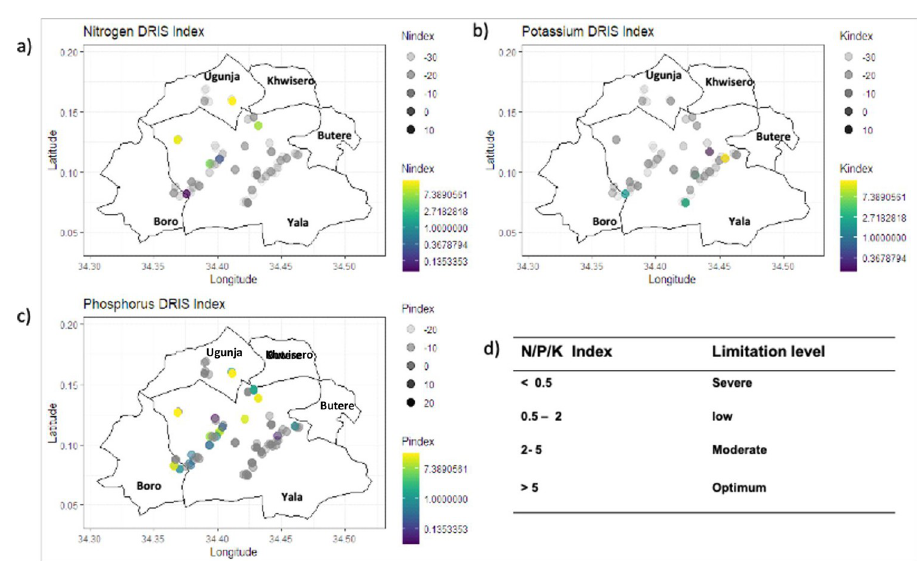
Fig 9. Maps showing the geographical location of maize fields and the spatial pattern of the intensity of nutrient limitations across the study area based on DRIS indices values for a) nitrogen, b) potassium and c) phosphorus.